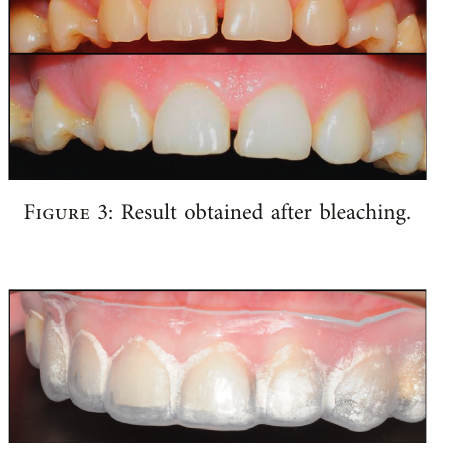
Figure 4: Silicone tray in position.